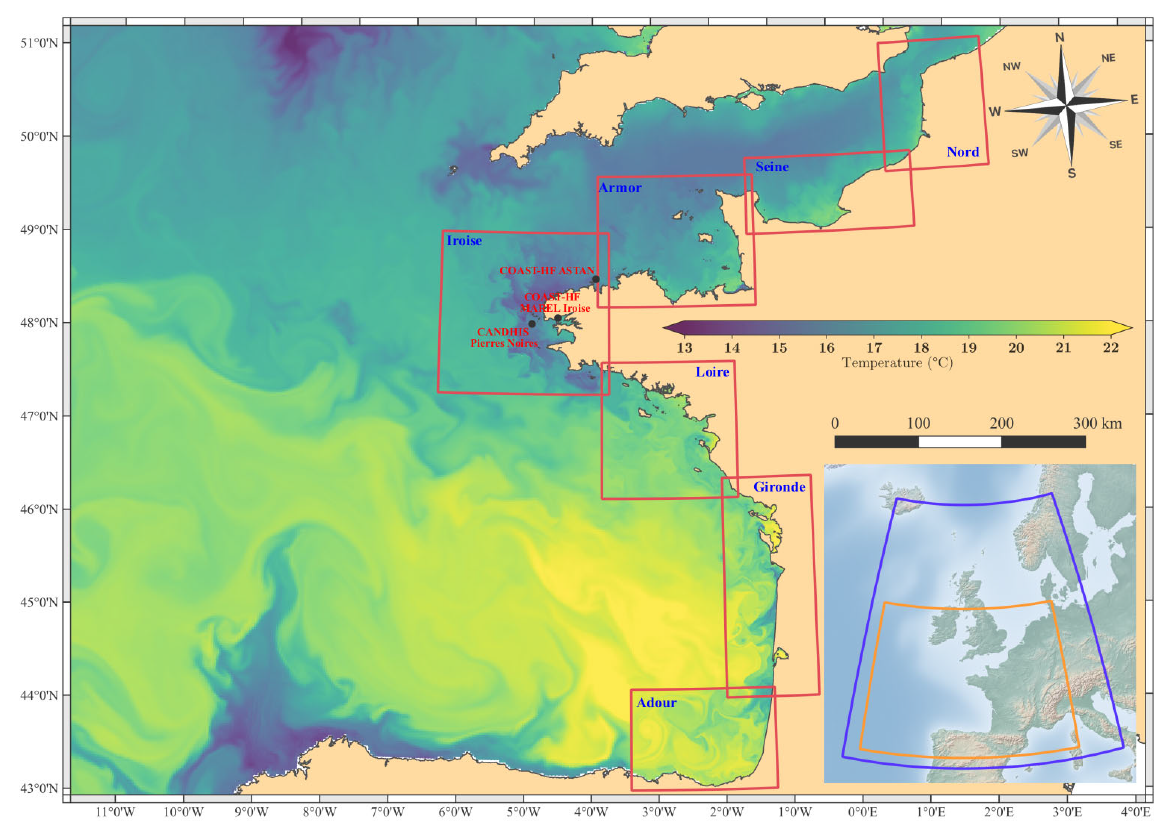
Figure 5. A Bay of Biscay configuration with seven magnified views at 500m resolution (red rectangles). The 2.5km resolution coarser grid (orange rectangle) is included in a larger 2D model at 5km resolution (blue rectangle). The sea surface temperature is given for 16 Au- gust 2018 with the finest possible resolution. Bathymetric and coastline sources: Ifremer, Service hydrographique et océanographique de la marine (SHOM) and Natural Earth. Table 1. Mean computation time given in hours for both modeled configurations for a simulation of 45d.